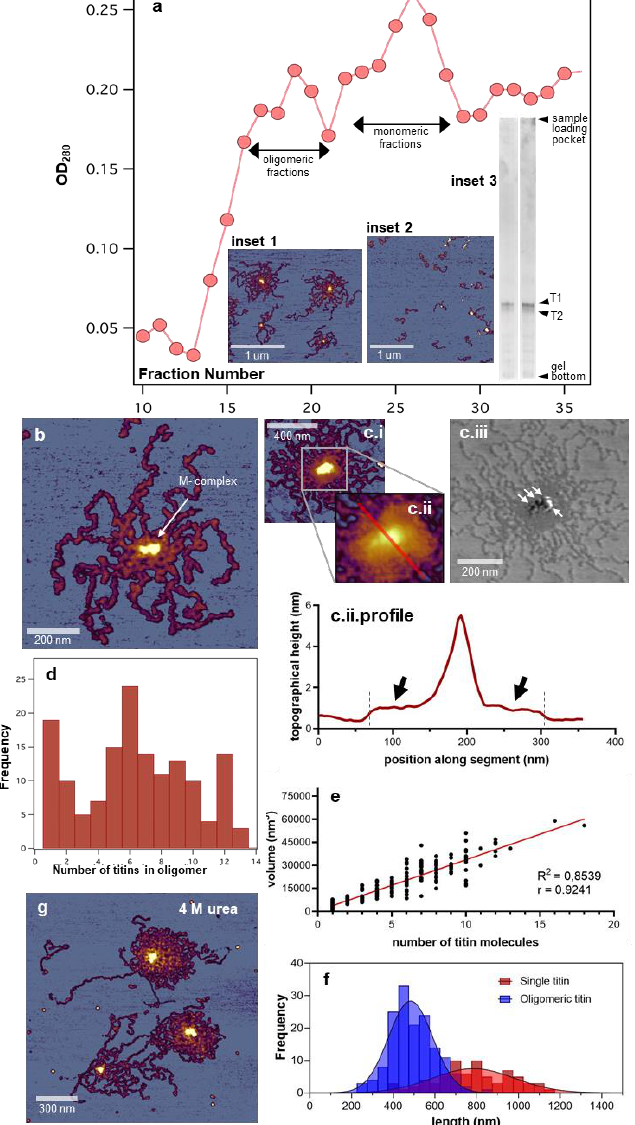
Figure 1. Preparation, overall structure, and stability of the titin M-complex. ( a ). Sepharose CL-2B gel filtration elution profile of our titin sample. ( Inset 1 , Inset 2 ) show AFM images of oligomeric and monomeric fractions, respectively. ( Inset 3 ) shows the SDS agarose (0.8 %) gel profiles of purified titin samples. Left and right lanes are representative for oligomeric and monomeric fractions, respectively. ( b ). AFM image of a typical titin oligomer. The arrow points at the M-complex, which is the focal point of head-to-head association between the component titin molecules. ( c.i ). AFM image of a titin oligomer comprising a large number of titin molecules. ( c.ii ). Enlarged view of the middle region of the titin oligomer. Red line marks the section used for obtaining a topographical profile along the center of the M-complex. ( c.ii.profile ). Topographical height profile along the line in c.ii. The arrows point at a plateau region that appears around the M-complex. The dashed lines indicate the edges of the plateau region. ( c.iii ). Phase-contrast AFM image of the titin oligomer shown in c.i. Arrows point at resolvable M-complex subunits. ( d ). Histogram of the number of titin monomers in the oligomer. Local modes appear at 6 and 12. ( e ). Volume of the M-complex, measured from AFM data, as a function of the number of titin molecules in the oligomer. ( f ). Distribution of the resolvable contour length of titin in monomers (“single titin”) and oligomers. The r 2 values for the gaussian fits to the oligomeric and single-titin data are 0.85 and 0.47, respectively. ( g ). Height-contrast AFM image of titin oligomers in 4 M